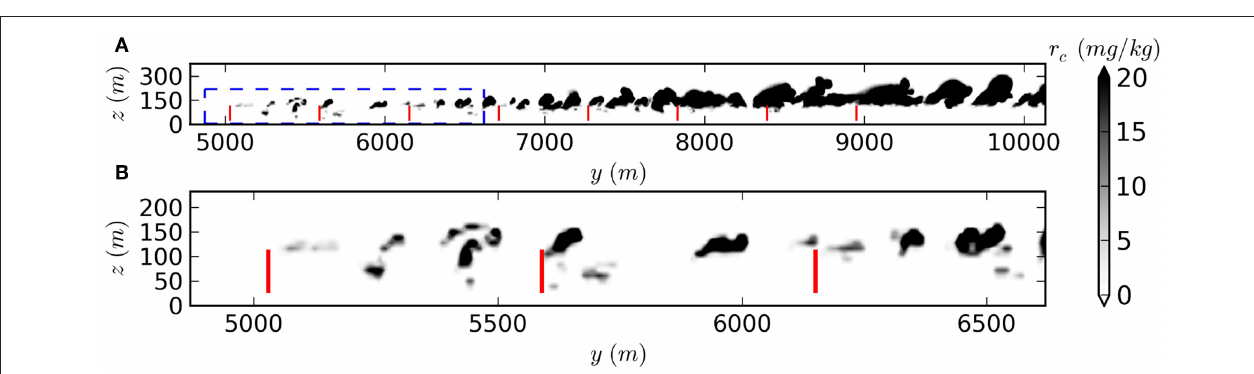
conditions for the second simulation where the full wind farm was introduced. With a post-processing of the cloud mixing ratio, two renders of the resulting cloud scenes were made. Their main